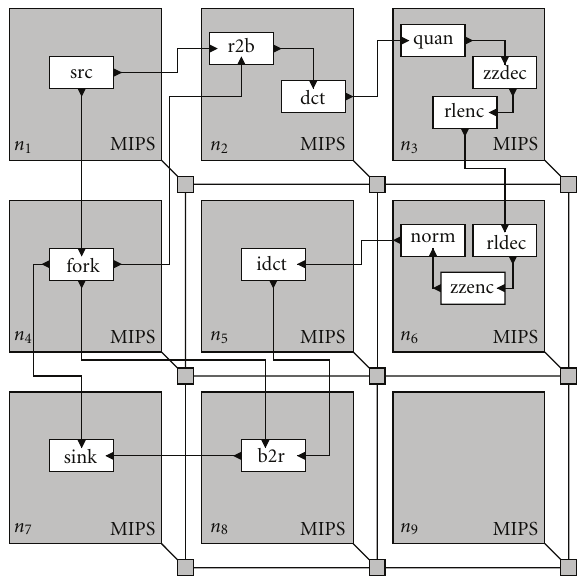
Figure 8: Mapping of JPEG application components on 3 × 3